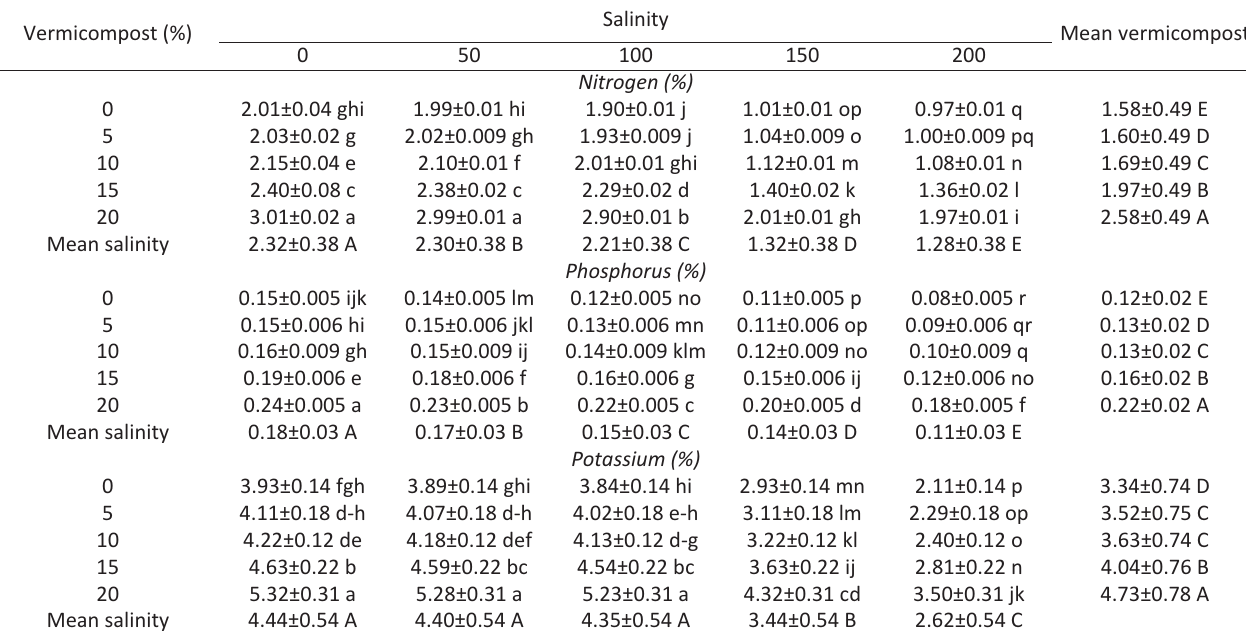
In each variable, data followed by the same letters (small letters for interactions and capital letters for means) are not significantly dif- ferent using LSD at 5%level. Data represent the mean value ± S.D. the mean of four